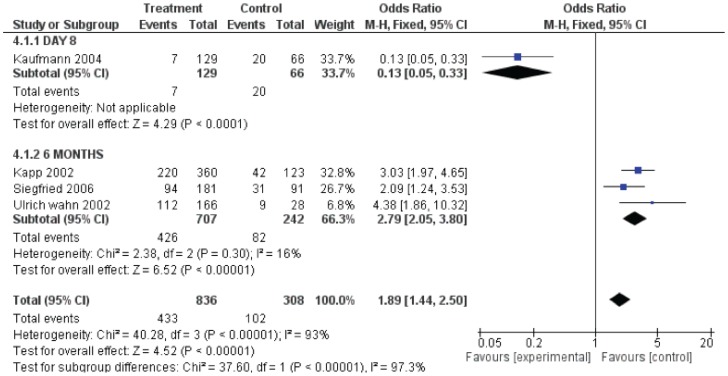
Analysis of flare free periods (pimecrolimus vs vehicle).